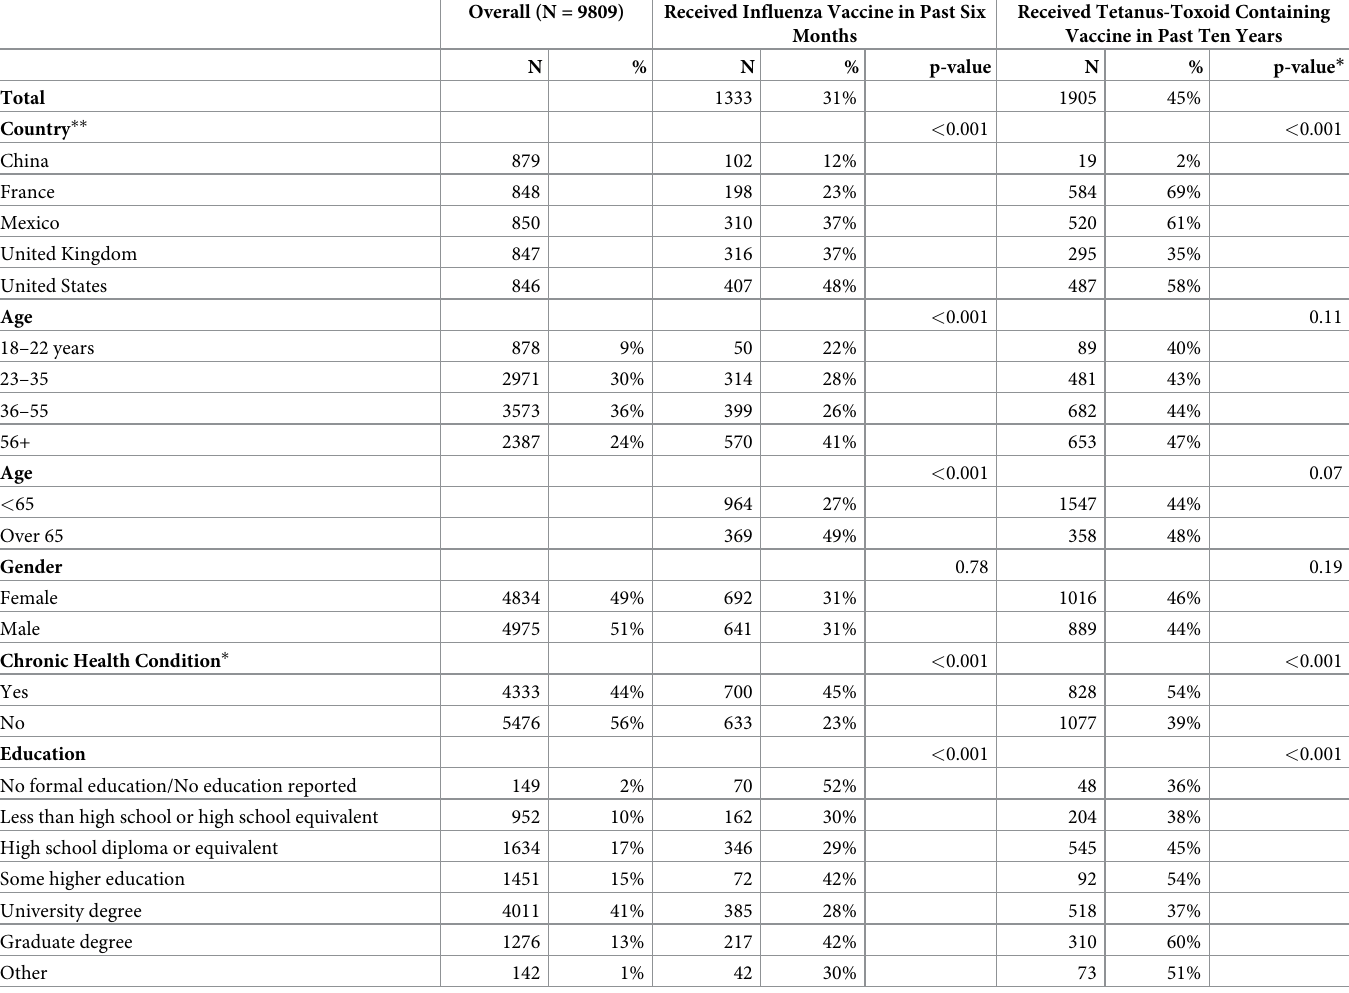
Table 2. Socio-demographic characteristics of the study population and vaccine receipt.